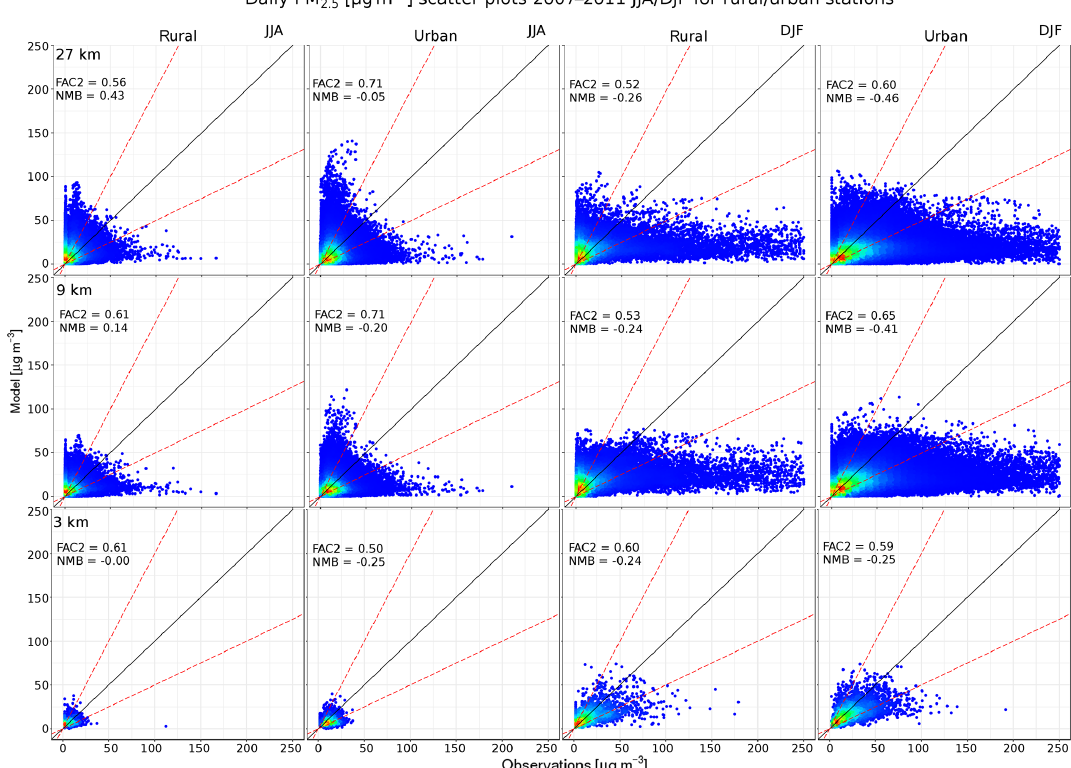
Figure 6. Scatter plots of daily PM 2 . 5 values for JJA (columns 1 and 2) and DJF (columns 3 and 4) for rural and urban stations in µgm − 3 . The rows represent different model resolutions from 27km (top) to 3km (bottom). Dot colors stand for the density of the model–observation pairs. Dashed red lines define the FAC2 region. Calculated values of FAC2 and the NMB are indicated